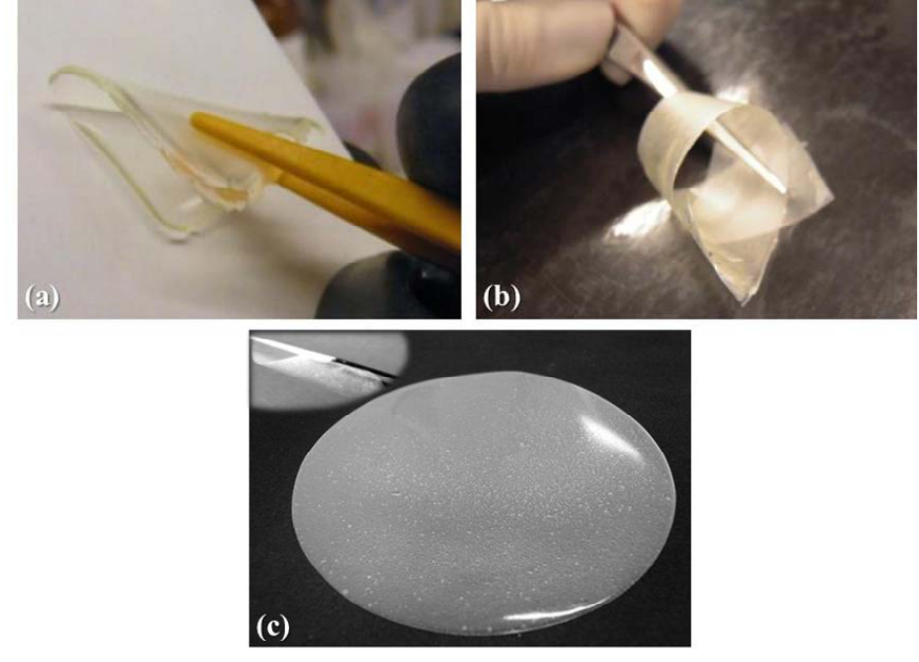
flux (temperature range 25–600 °C) for the RC-1 2